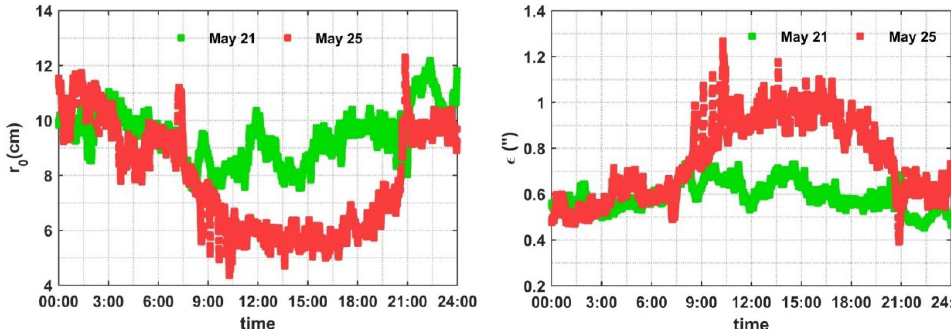
Figure 12. Diurnal profiles of r 0 and ε over the two